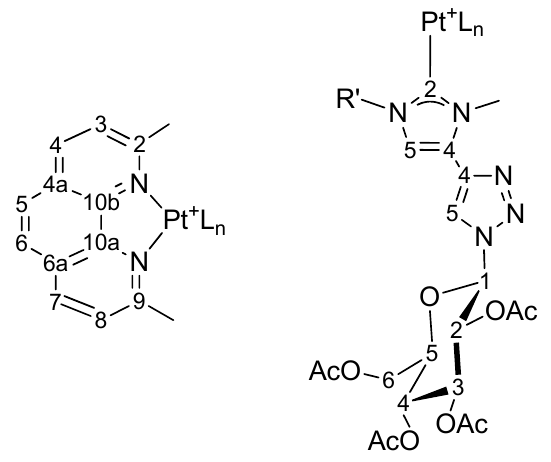
Figure 11. Numbering scheme for the carbon atoms within the rings.